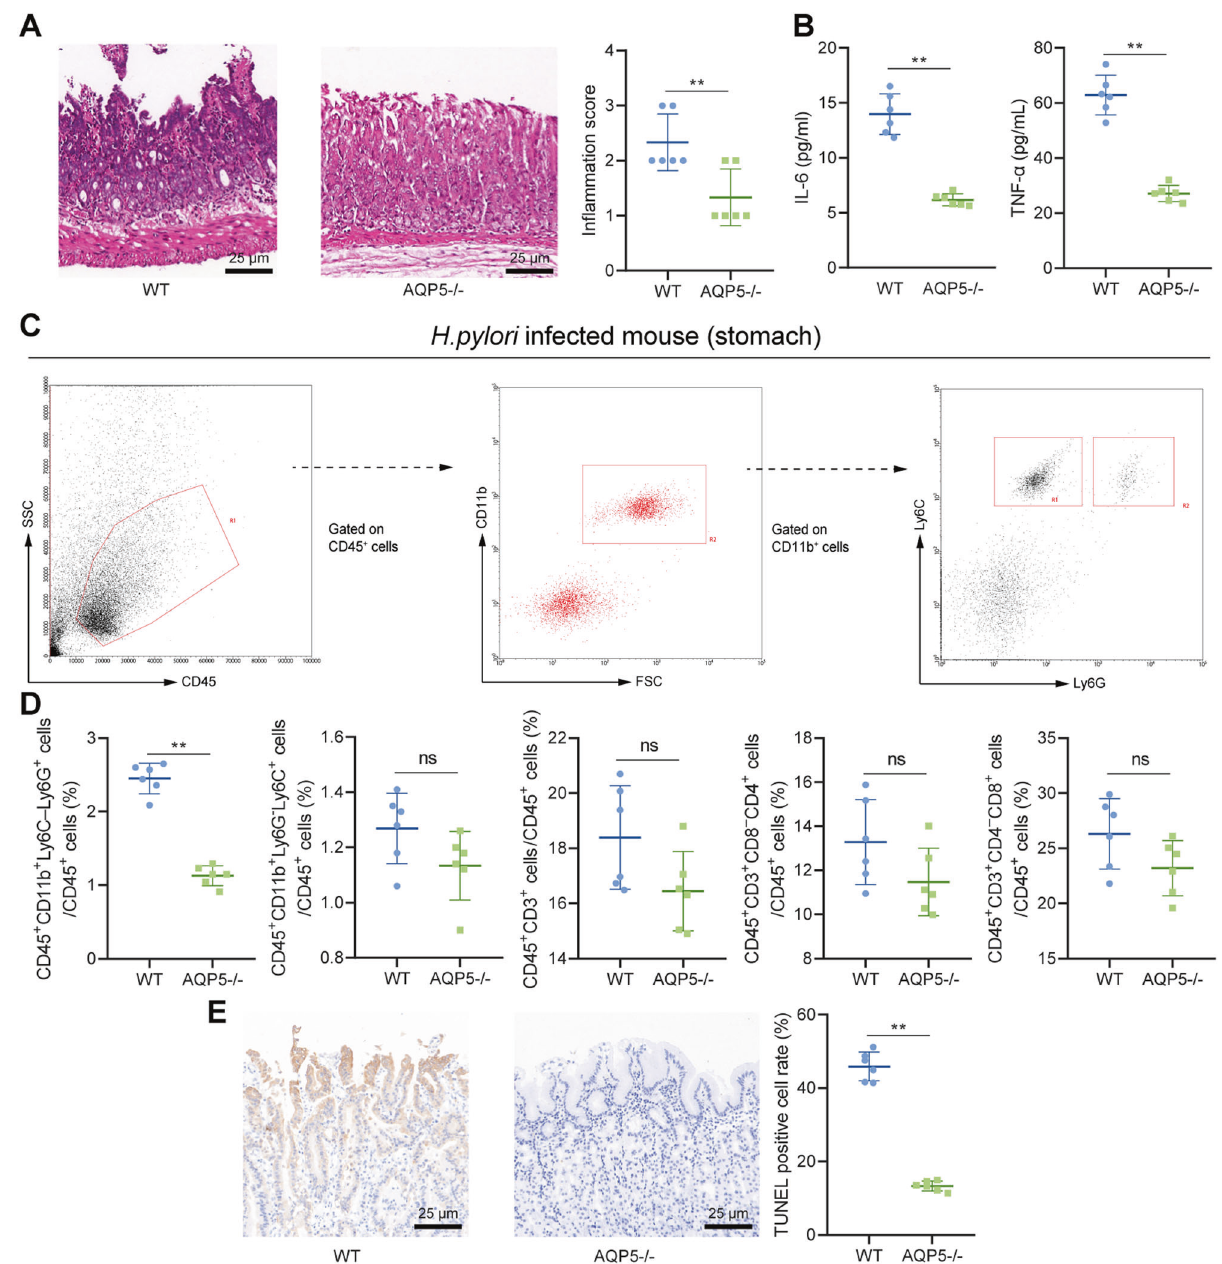
(CD45 + CD11b + Ly6C – Ly6G + ) and monocytes (CD45 + CD11b + Ly6G – Ly6C + ). D The contents of immune cells in gastric mucosa of mice by independent sample t-